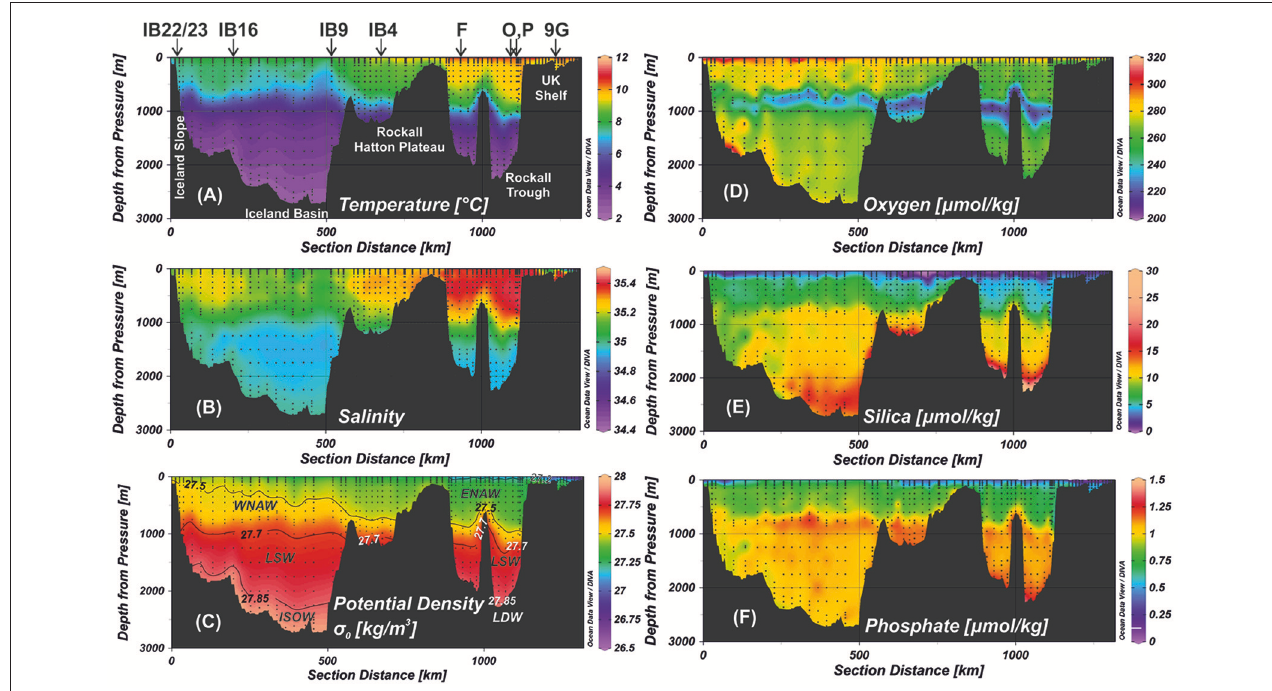
FIGURE 2 | Sections of: (A) temperature ( ◦ C), (B) salinity, (C) potential density σ θ (kg/m 3 ), (D) dissolved oxygen ( µ mol/kg), (E) silica ( µ mol/kg), (F) phosphate ( µ mol/kg). The potential density section has contours delineating the ranges identified by Holliday et al. (2015) as representative of different water masses, with acronyms identifying the dominant water mass (see Figure 1 caption for acronyms). The data are from 920 bottle samples (black dots) collected from 85 stations over ∼ 1,300km of cruise track during the 2015 EEL campaign. The figure was created using ODV software, available at https://odv.awi.de/ ( Schlitzer, 2016).